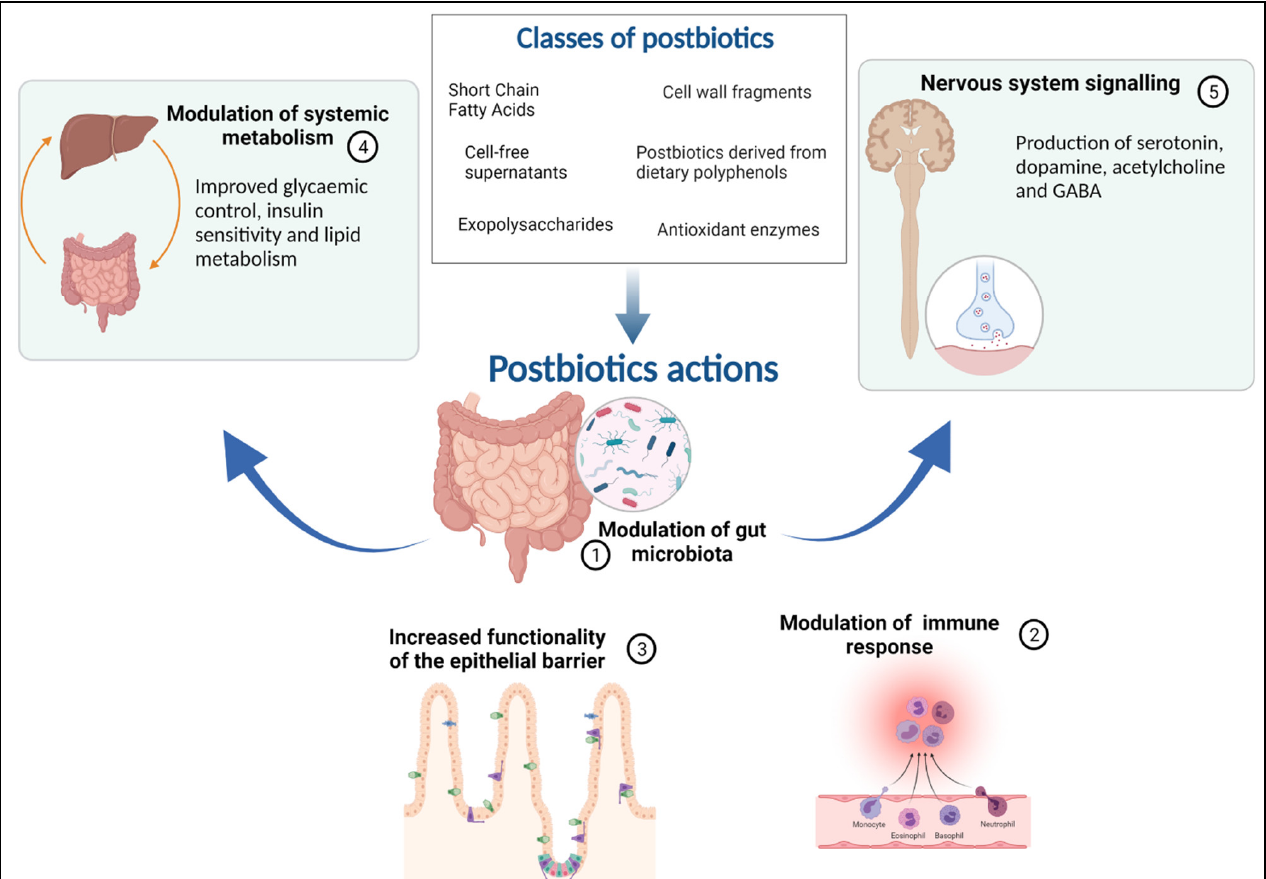
Figure 1. The five mechanisms of action of postbiotics: modulation of the resident microbiota, enhancement of epithelial barrier functions, modulation of local and systemic immune responses, modulation of systemic metabolic responses, and systemic signalling via the nervous system.